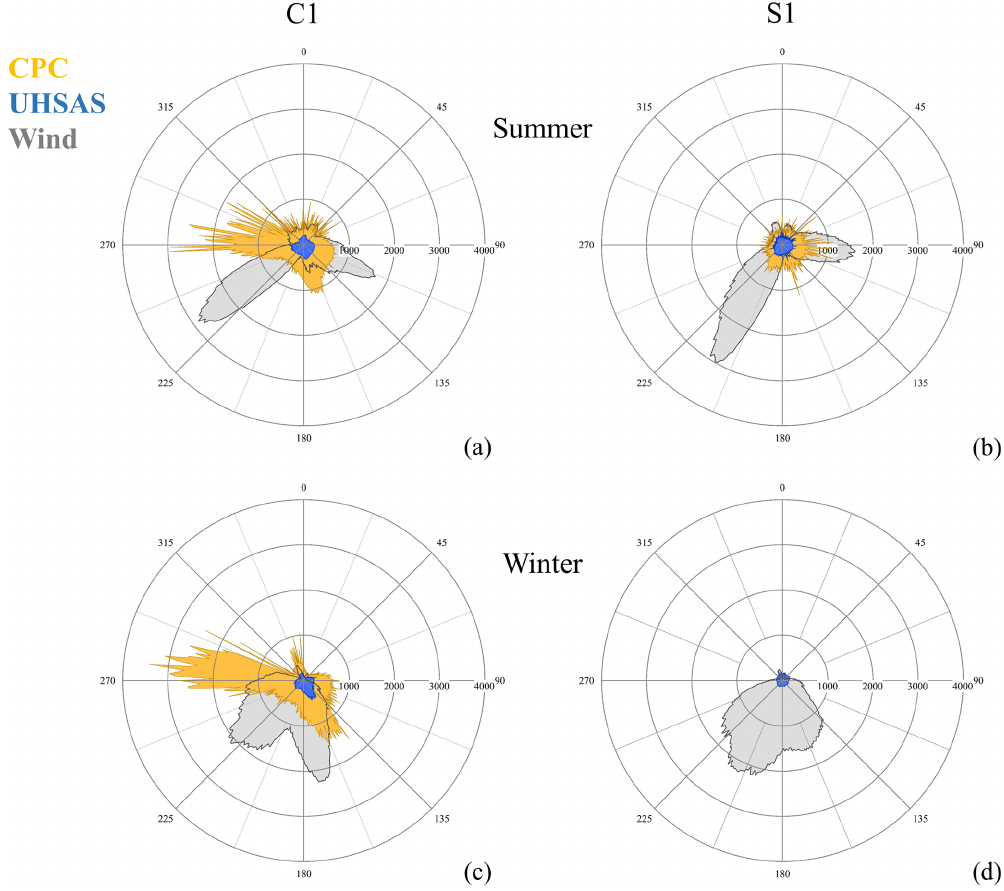
Figure 3. Polar graphs of the mean N tot and N UHSAS as a function of wind direction during summer (a, b) and winter (c, d) at C1 and S1. The 1min N tot data from the CPC, in orange (data not available at S1 in the winter), and N UHSAS from the UHSAS, in blue, were averaged as a function of wind degree direction. The frequency of wind direction is in